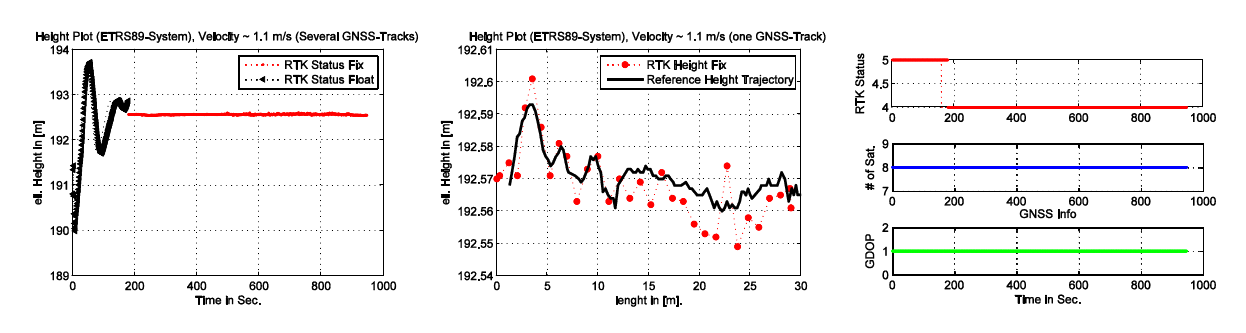
Figure 3. Results of the first Test Measurement at Moba